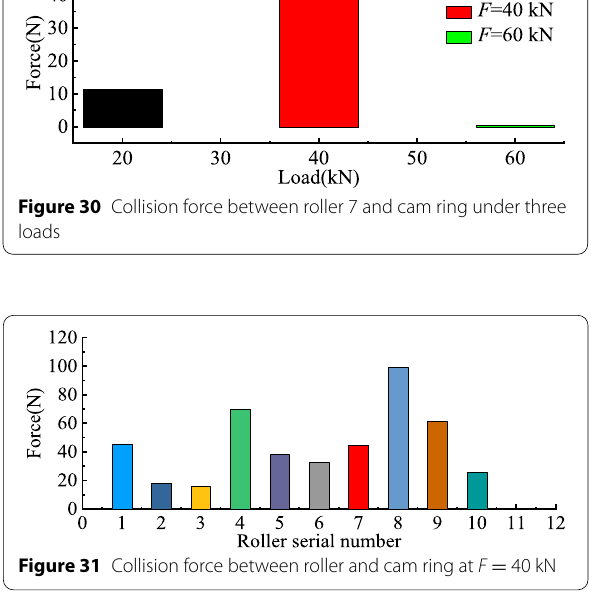
force between the twelve rollers and the cam ring at F roller and the carrier under three loads, respectively.